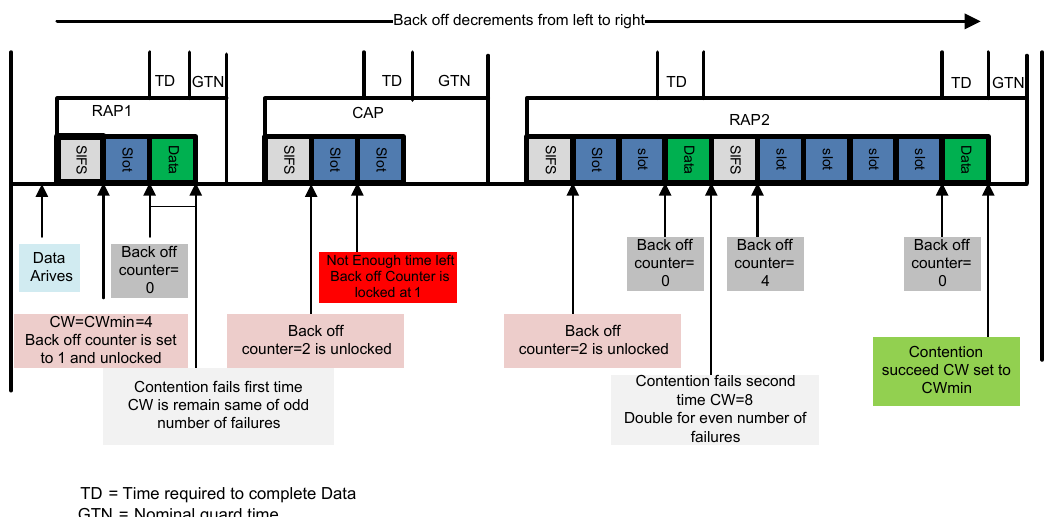
Figure 4. Superframe structure of beacon enabled mode.